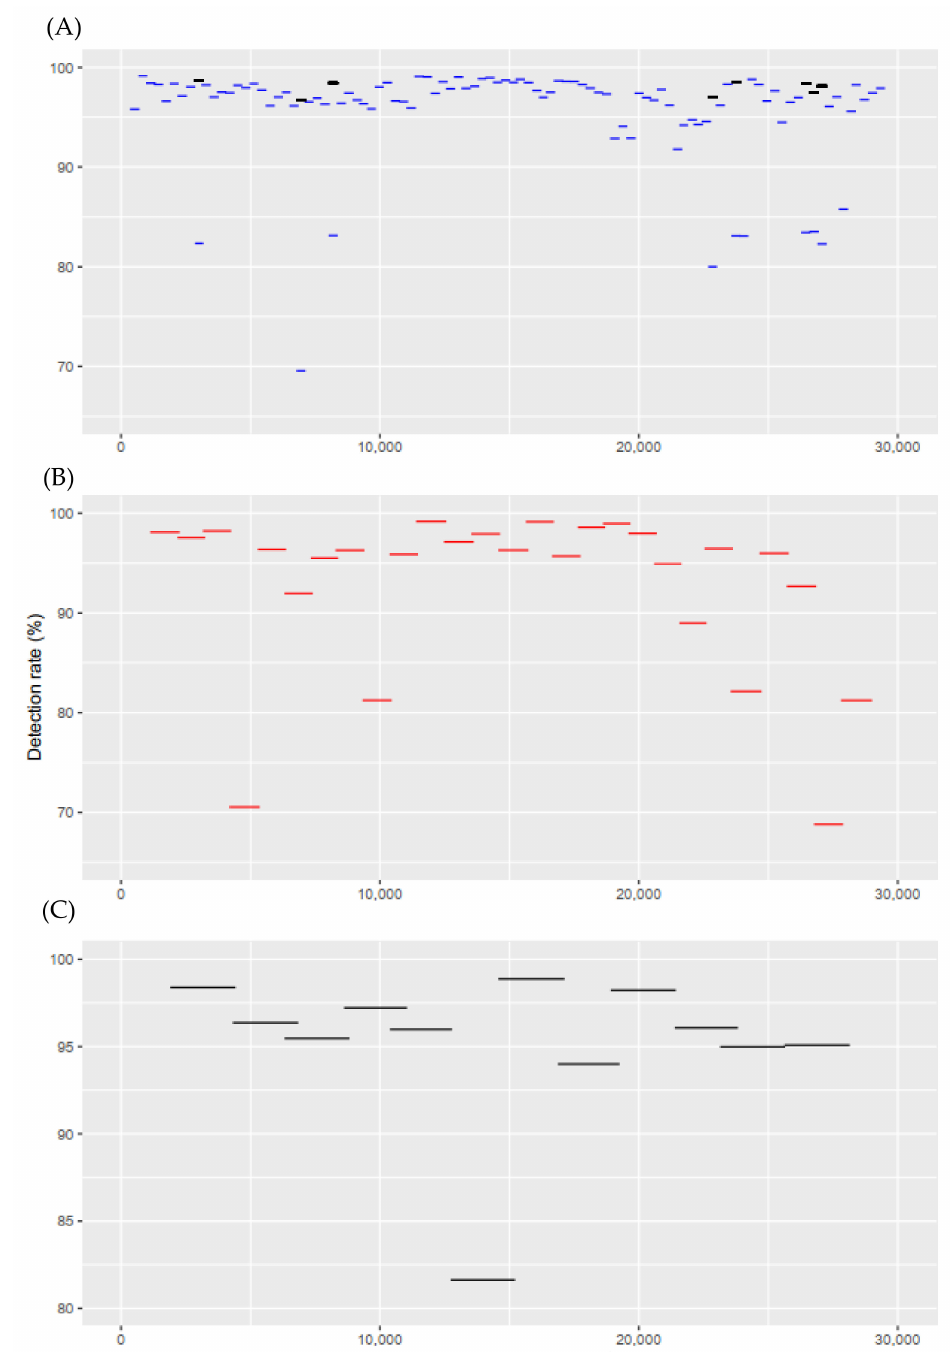
Figure 1. In silico evaluation of primer sets across the SARS-CoV-2 genome. ( A ) Set I: ARTIC nCoV-2019 V4, updated primers (primer pairs 10, 23, 27, 76, 79, 88, 89, and 90 were updated in V4.1) in black lines, ( B ) set II: SARS-CoV-2-Midnight, and ( C ) set III: 1.4 × 2.5 kb amplicons. An amplicon-wise detection rate corresponding to each primer pair was determined: No. of genome containing the sequences of primer pair/Total number of genomes 848,003 SARS-CoV-2 genome sequences downloaded from NCBI on 14 February